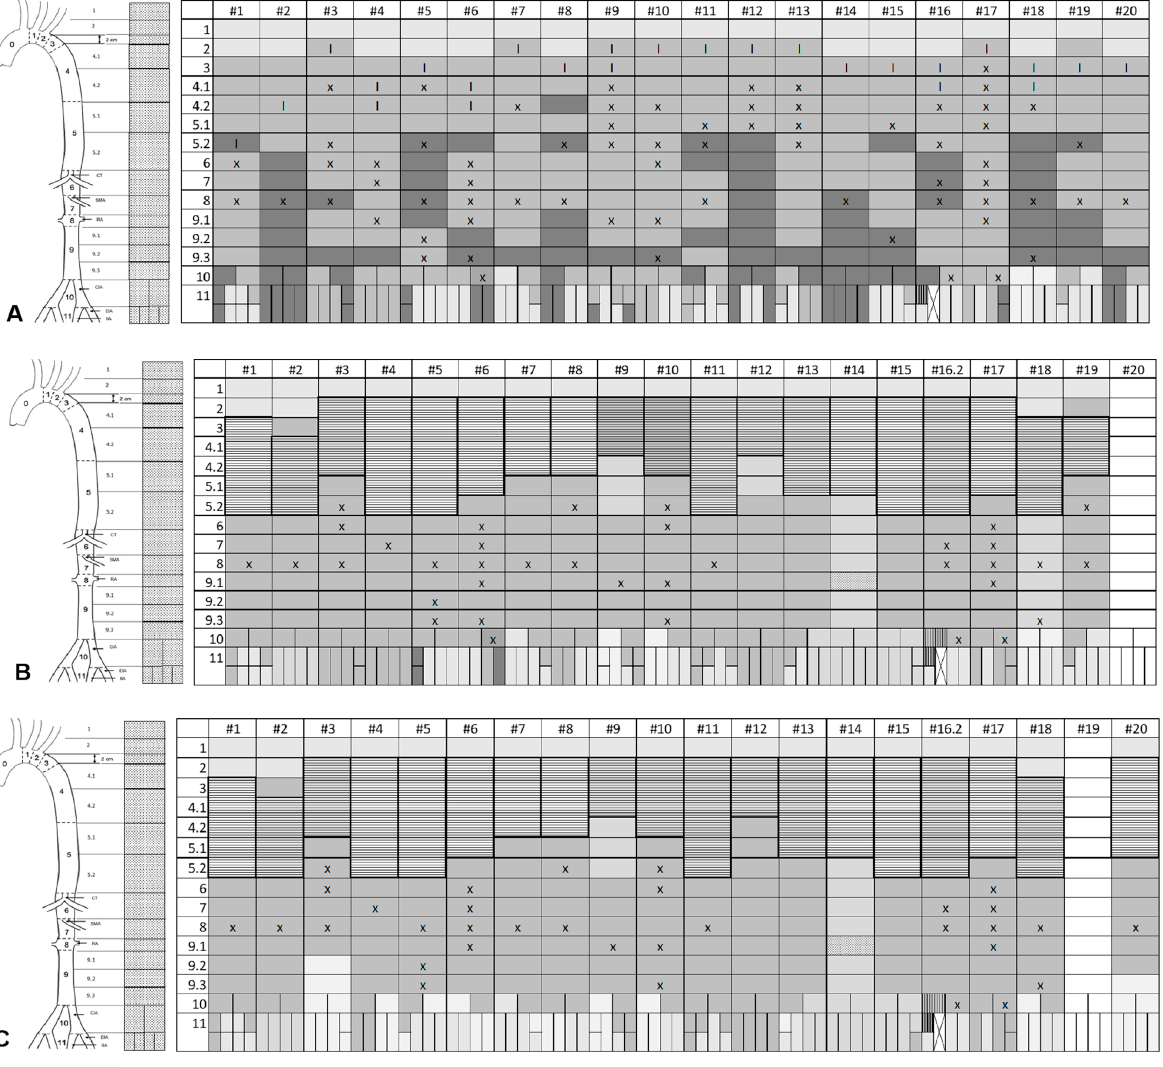
Figure 5. Secondary rearrangement according to morphological distribution patterns, comparing TEVAR alone with TEVAR + extremity related adjunct procedure (erAP) cases. Graphical analysis of the evaluated parameters showed a relation between the start- ing point and the extent of the TLC regarding TEVAR success. (Figures 6 and 7A,B). In addition, the first re-entry was located slightly further downstream in cases treated with TEVAR and erAP. The number of re-entries did not differ between TEVAR alone and TEVAR + erAP. Furthermore, neither the extent of the primary entry tear nor the